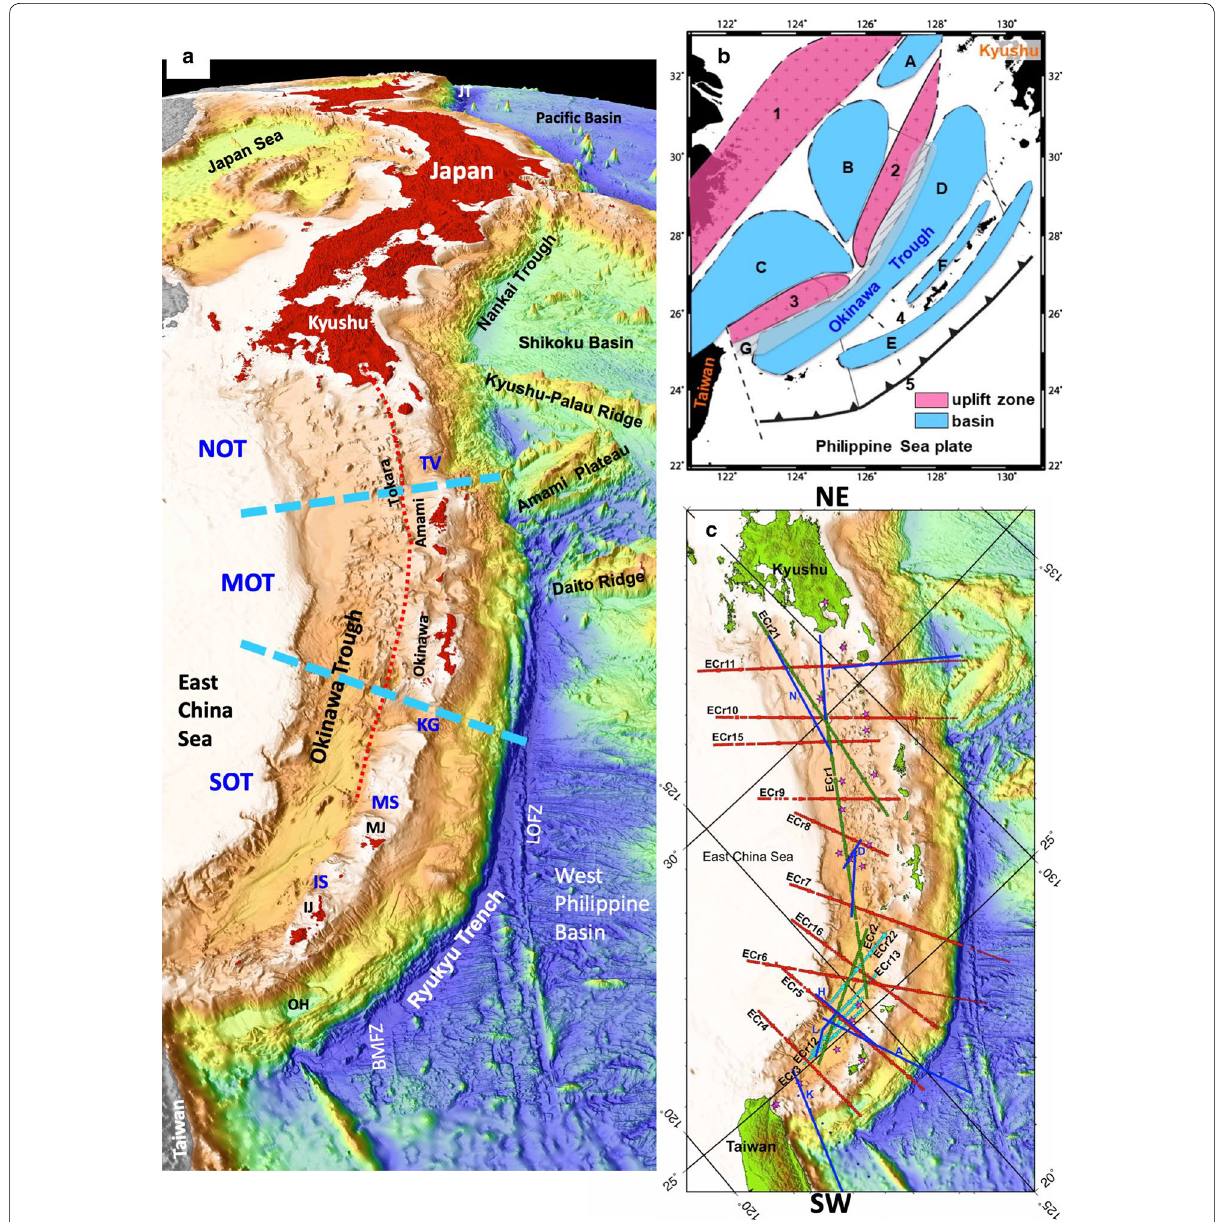
Fig. 1 a Tectonic map in and around the Okinawa Trough (OT). Sky-blue dashed lines indicate westward extension of the Tokara Valley and Kerama Gap. NOT northern Okinawa Trough, MOT middle Okinawa Trough, SOT southern Okinawa Trough, TV Tokara Valley, KG Kerama Gap, MS Miyako Saddle, IS Ishigaki Saddle, MJ Miyako-jima, IJ Ishigaki-jima, LOFZ Luzon-Okinawa fracture zone, BMFZ Botan–Miyako fracture zone, OH Oki– Hateruma Basin. Red dotted line shows the volcanic front. b Scheme of the tectonic provinces in the East China Sea summarized by Inoue (2007). 1, Fukien-Reinan Massif; 2, Goto Uplift Zone; 3, Senkaku Uplift Zone; 4, Ryukyu Arc; 5, Ryukyu (Nansei-Shoto) Trench; A, Goto Basin; B, Tungai Basin; C, Senkaku Basin; D, Okinawa Trough; E, Ryukyu forearc basin; F, Amami Basin (Kizaki, 1985); A B C, East China Sea Basin (Taiwan Basin), G, Basin + + under Tungai Slope (Kimura 1990). c Location of the seismic lines. Red, green, and sky-blue lines are the across-trough, along-trough, and along-rift/ rift-parallel survey lines, respectively. Blue lines indicate positions of previous surveys. Iwasaki et al. (1990), Nakahigashi et al. (2004), Nagumo et al. (1986), Hirata et al. (1991), Lee et al. (1980), Arai et al. (2017), Klingehoefer et al. (2009). Violet asterisks show hydrothermal vents (http://vents -data. inter ridge .org/ventfi elds ?order name_3&sort = =